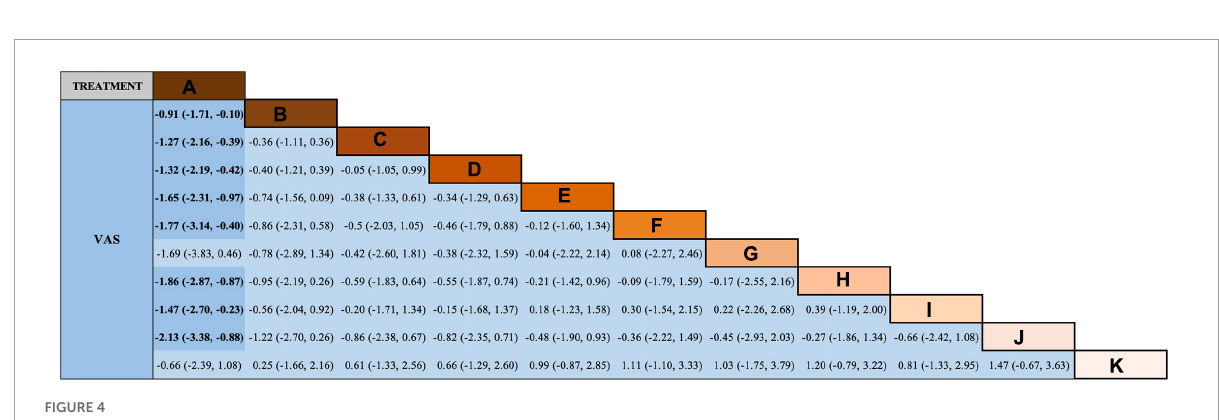
FIGURE4 Network meta-analysis (NMA) results of visual analog scale (VAS). A = antiepileptics; B = manual acupuncture; C = electroacupuncture; D = fire needling; E = pricking and cupping; F = Fu’s acupuncture; G = medicated thread moxibustion; H = electroacupuncture plus antiepileptics; I = fire needling plus antiepileptics; J = pricking and cupping plus antiepileptics; K = acupoint catgut embedding plus